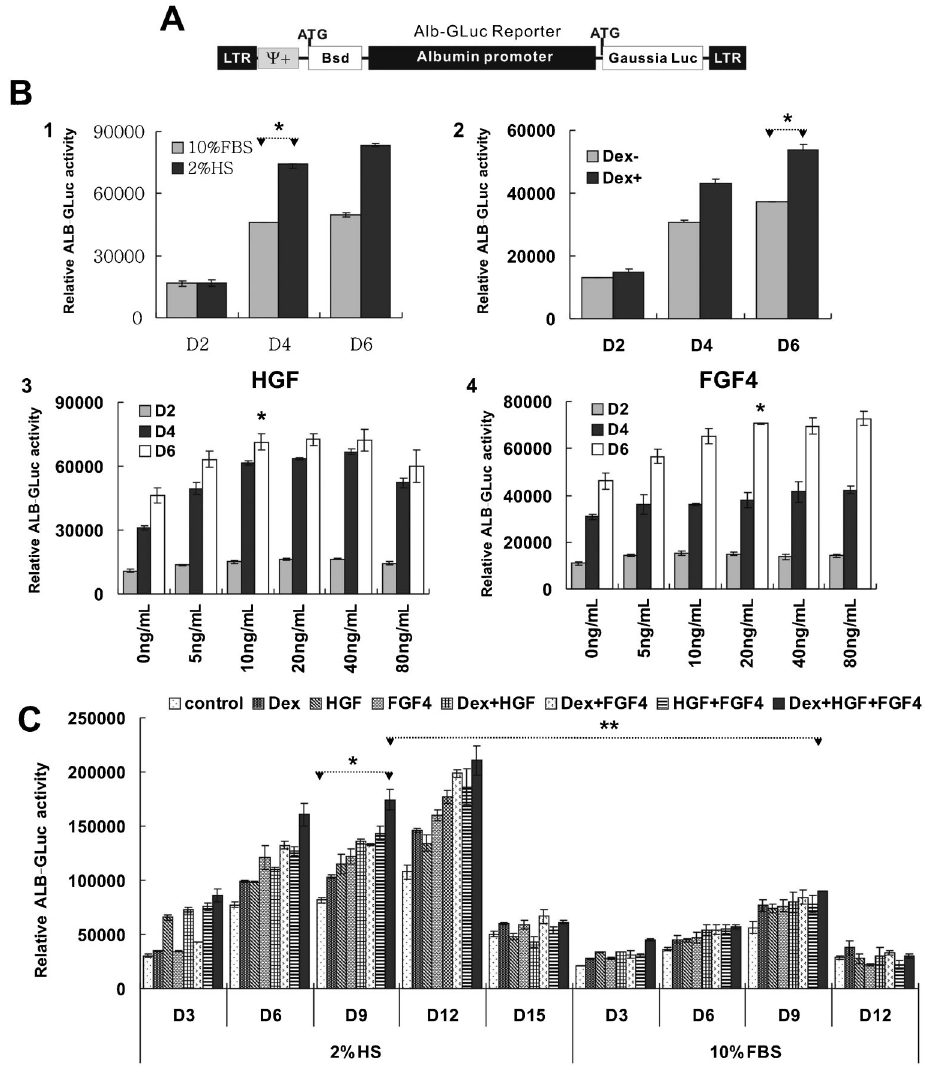
Figure 1. Effect of different induction factors on albumin promoter-driven Gaussian luciferase (ALB-GLuc) activity. HP14.5 ALB-Gluc cells were treated with induction factors. ALB-GLuc activity was assayed on the indicated day (D). A , Schematic representation of the ALB-GLuc reporter. B , ALB-GLuc activity of HP14.5 cells at D2, D4, and D6 treated with ( 1 ) different complete DMEM medium with 10% fetal bovine serum (FBS) and 2% horse serum (HS) (*P , 0.05, two-tailed Student t -test); ( 2 ) 0.1 m M dexamethasone (Dex) in 10% FBS medium (*P , 0.05, two-tailed Student t -test); ( 3 ) different concentrations of hepatic growth factor (HGF) (*P , 0.05, 10 ng/mL vs 0 ng/mL control, two-tailed Student t -test); ( 4 ) different concentrations of fibroblast growth factor 4 (FGF4) (*P , 0.05, 20 ng/mL vs 0 ng/mL control, two- tailed Student t -test). C , ALB-GLuc activity of HP14.5 cells at D3, D6, D9, D12, and D15 with single factors and different combinations of culture conditions. Three independent assays were carried out for each group. *P , 0.05, Dex++HGF++FGF4 vs control with 2% HS; **P , 0.05, Dex++HGF++FGF4 with 2% HS compared to the same treatment with 10% FBS (two-tailed Student t